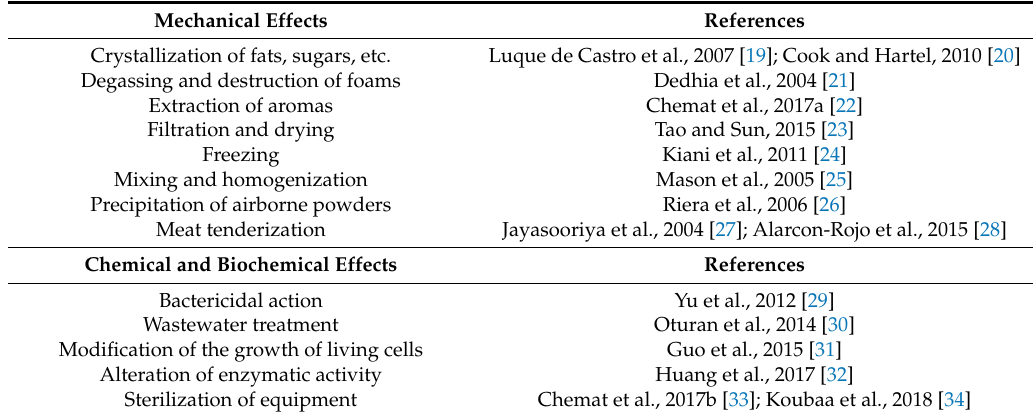
Table 1. Mechanical, chemical, and biochemical effects of